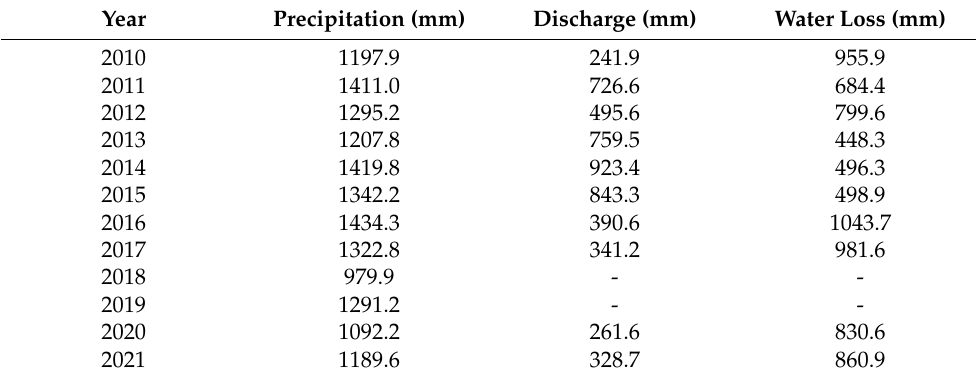
Table 2. Annual water balance at the Mount Karasawa study area.